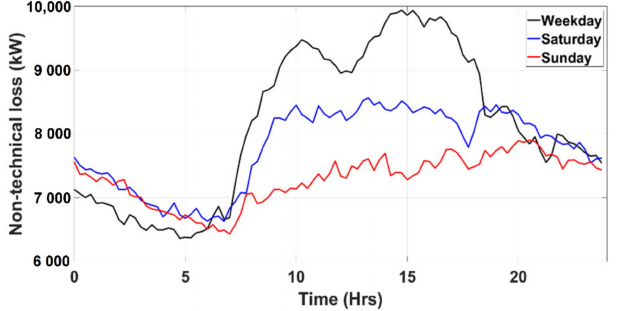
Figure 19. Non-technical losses for weekday (black), Saturday (red) and Sunday